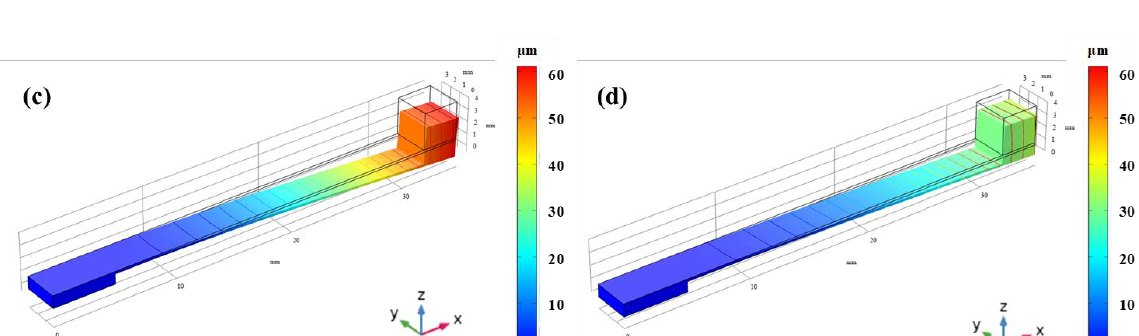
Figure 6. Von mises stress and total displacement profiles of LGS cantilever beam in different prop- agation directions with an acceleration of 1 g. ( a )Acceleration = 1 g φ = 35° Von Mises Stress ( b ) Acceleration = 1 g φ = 35° Total Displacement ( c ) Acceleration = 1 g φ = 90° Von Mises Stress ( d ) Acceleration = 1 g ϕ = 35 ◦ Total Displacement ( c ) Acceleration = 1 g ϕ = 90 ◦ Von Mises Stress ( d ) Acceleration = 1 g φ = 90° Total Displacement. Acceleration = 1 g ϕ = 90 ◦ Total